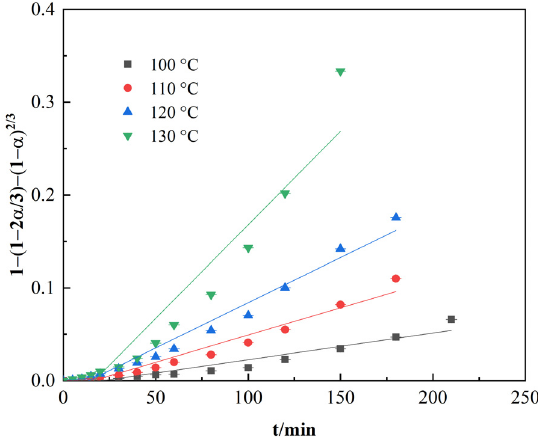
Figure 6. Effect of phosphate concentration on the leaching efficiency of tungsten.